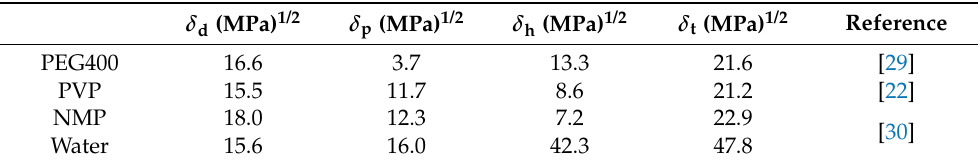
Table 5. Solubility parameters of the pore-forming agents, solvent, and